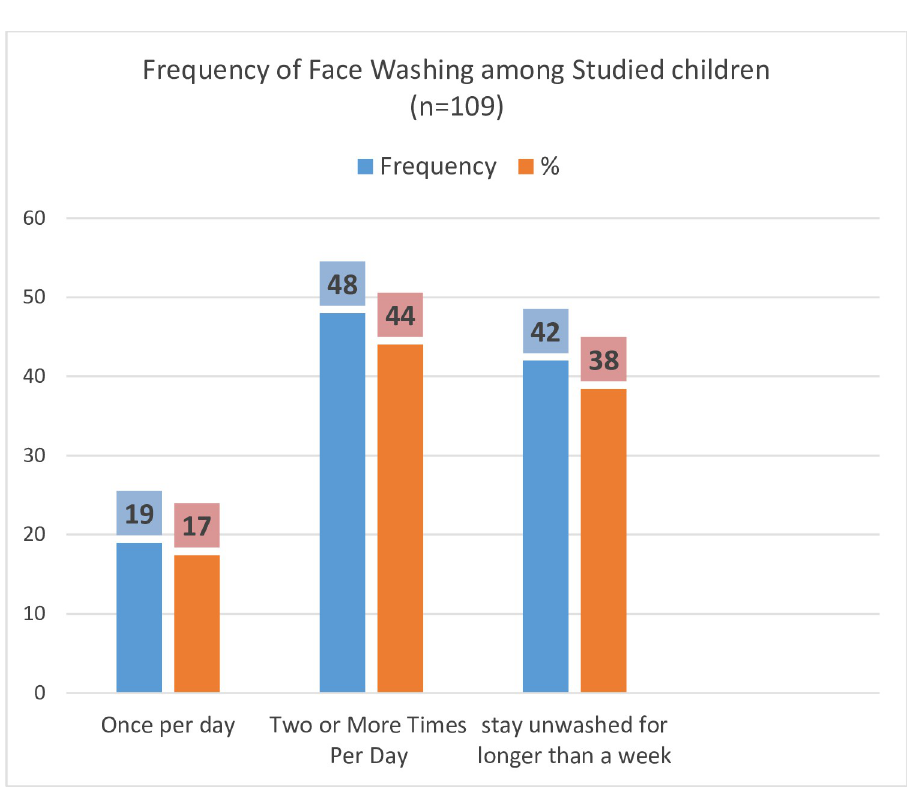
Fig 2. The frequency of face washing among children aged 1–9 years in Arsi Negele town.